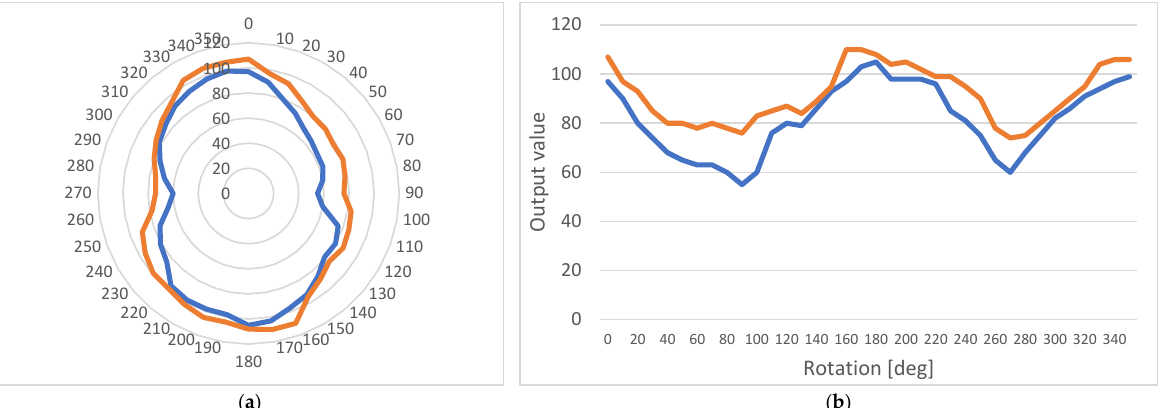
Figure 18. Anisotropic behavior of the sample before (blue line) and after (orange line) the flaw was added: ( a ) A polar diagram; ( b ) A linear diagram.